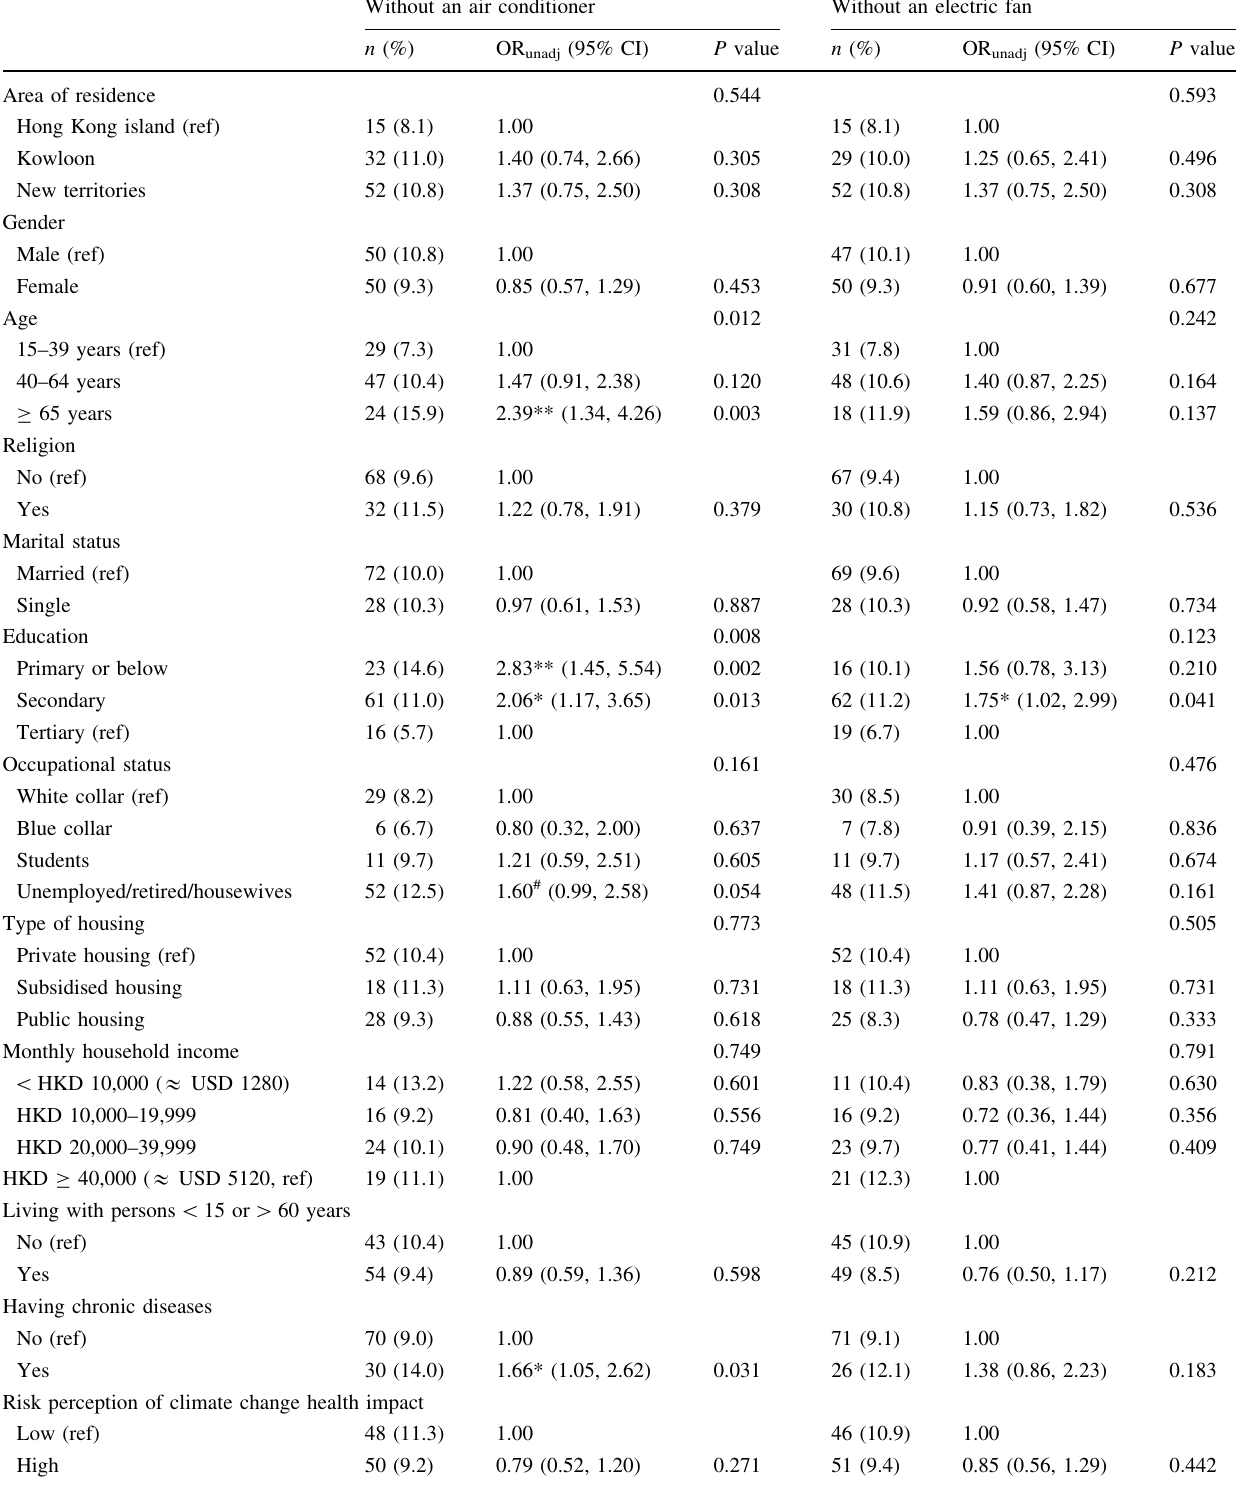
Table 3 Univariate logistic regression for ownership of cooling devices at home in the risk perception of climate change health impact survey in Hong